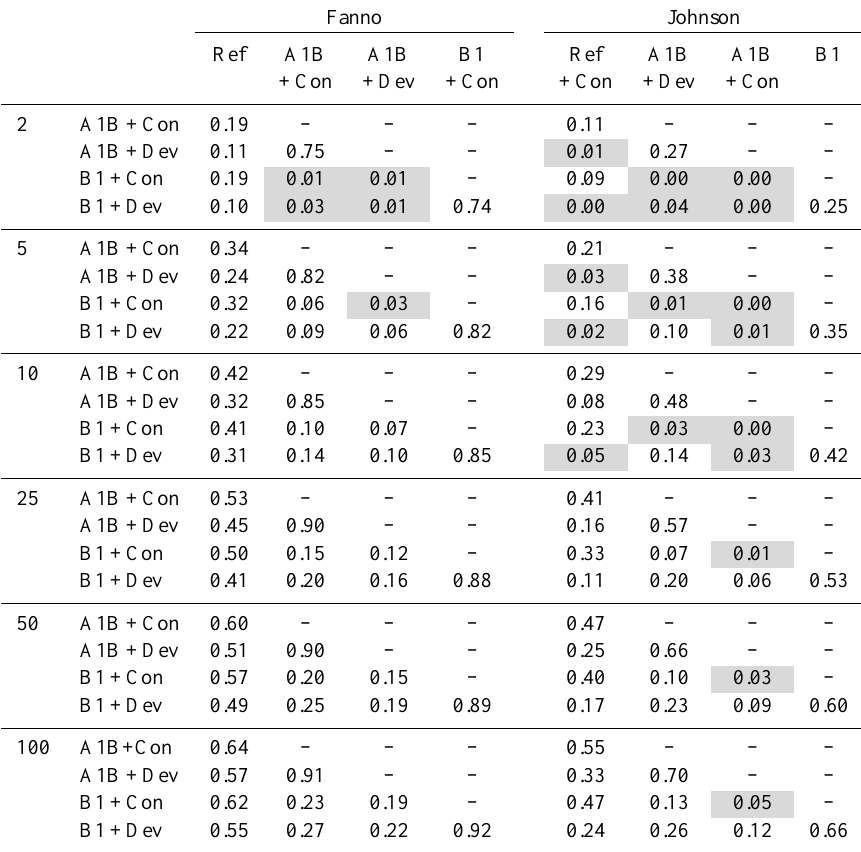
Table 4. t -test result of comparison between flood frequency change by combination of GHG emission scenarios and land use change scenarios. Shaded value indicates significant difference at the 95% confidence